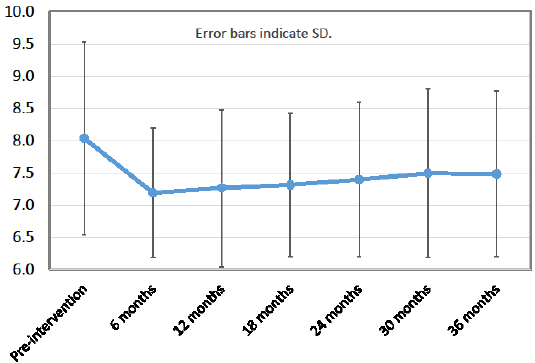
Figure 1. HbA1c level (%). Error bars indicate standard deviation ( n = 157).